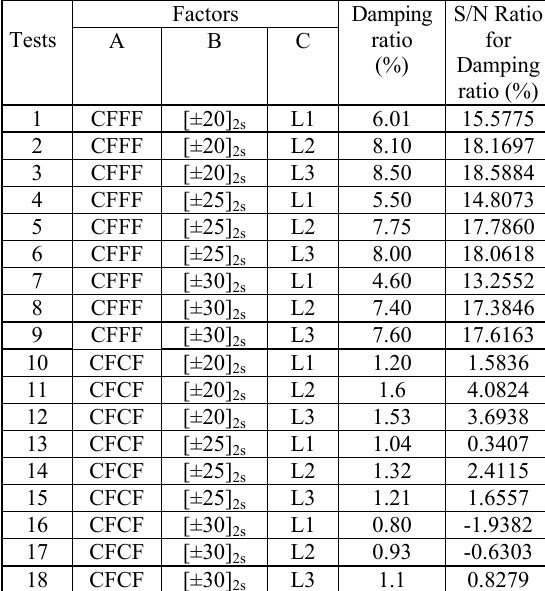
Table 9. The results of experiments